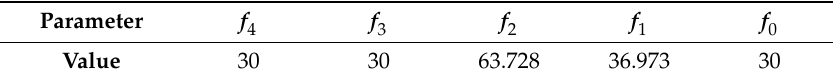
Table 3. Compensator numerator coe ffi cients.